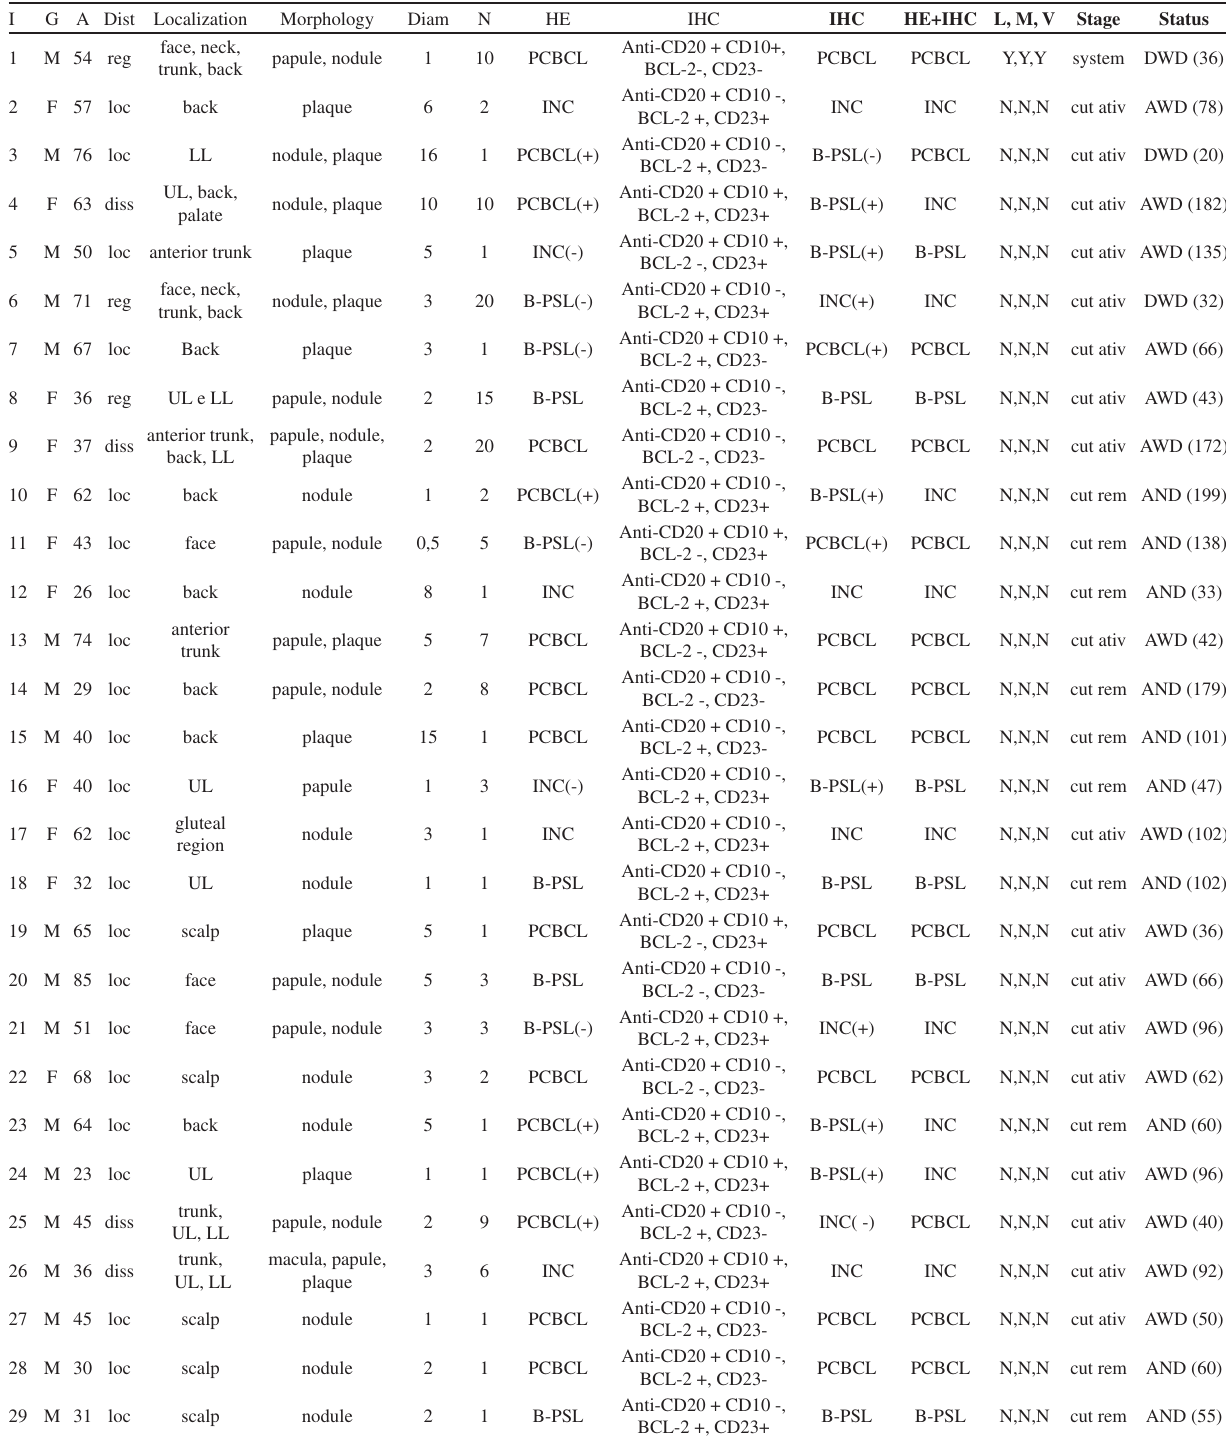
Table 1 - Clinical, histological and immunohistochemical data for 29 cases with B-cell lymphoproliferative